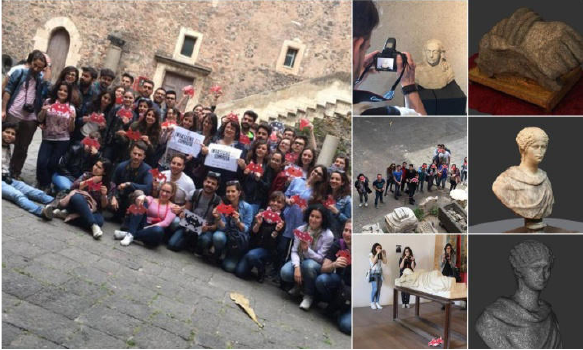
Figure 2. Students from University of Catania engaged in a crowdsourcing activity at Castello Ursino for the creation of 3D models starting from image dataset